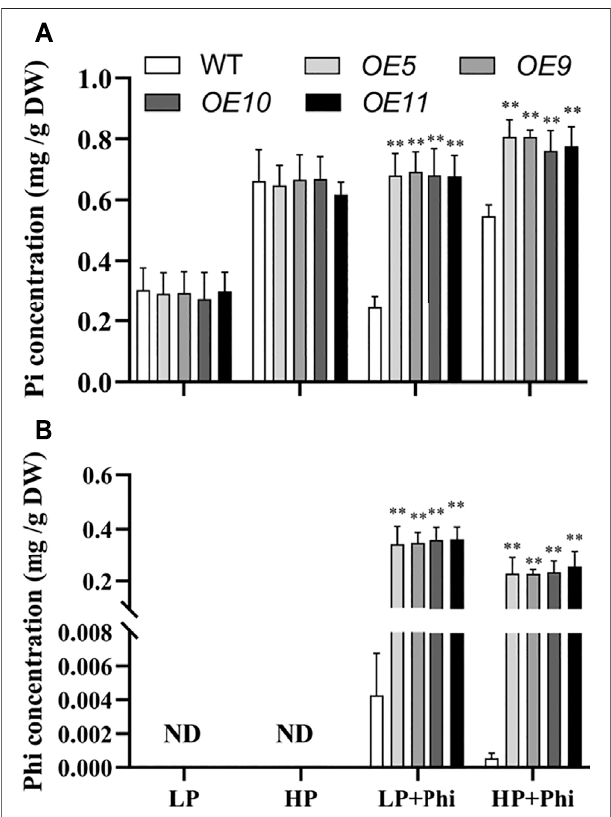
FIGURE 6 | Pi (A) and Phi (B) concentrations of WT ( ZH11 ) and ptxD Q ( OE5 , OE9 , OE10 , and OE11 ) transgenic rice grown under different phosphorus nutrient conditions. Fourteen-day-old seedlings were transferred to nutrient solutions containing 10 μ M phosphate (LP), 300 μ M phosphate (HP), 10 μ M phosphate plus 300 μ M phosphite (LP + Phi), or 300 mM phosphite plus 300 μ M phosphite (HP + Phi). The data are shown as means ± SD for fi ve replicates. Asterisks indicate signi fi cant differences as compared with WT plants (Turkey ’ s test, ** p ≤ 0.01).